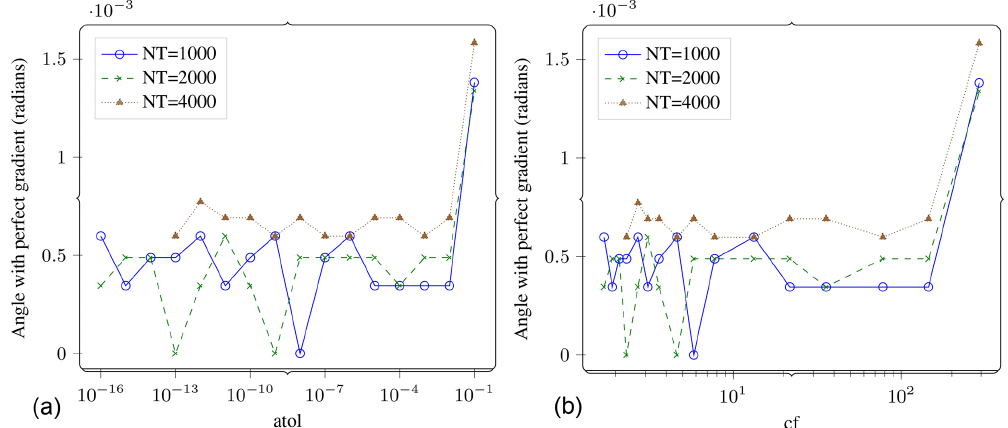
Figure 10. Gradient computation. Angle between the lossy gradient vector and the reference gradient vector (in radians) vs. atol (a) and vs. compression factor (b) . If the lossy gradient vector was pointing in a significantly different direction compared to the reference gradient, we could expect to see that on this plot. The angles are quite small. The number of time steps do not affect the result by much. The results are also resilient to increasing atol up to 10 − 2 . Compression factors of over 100x do not seem to significantly distort the results either.